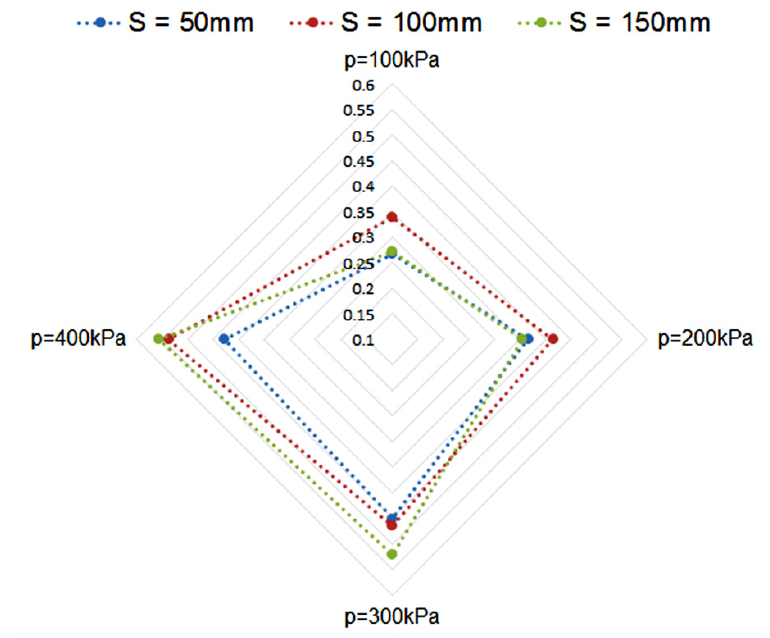
Figure 4. The amount of the chemical agent (g) on the seed potato surface for the valve without electronic control, depending on the falling path distance (mm) (continuous flow of the liquid).